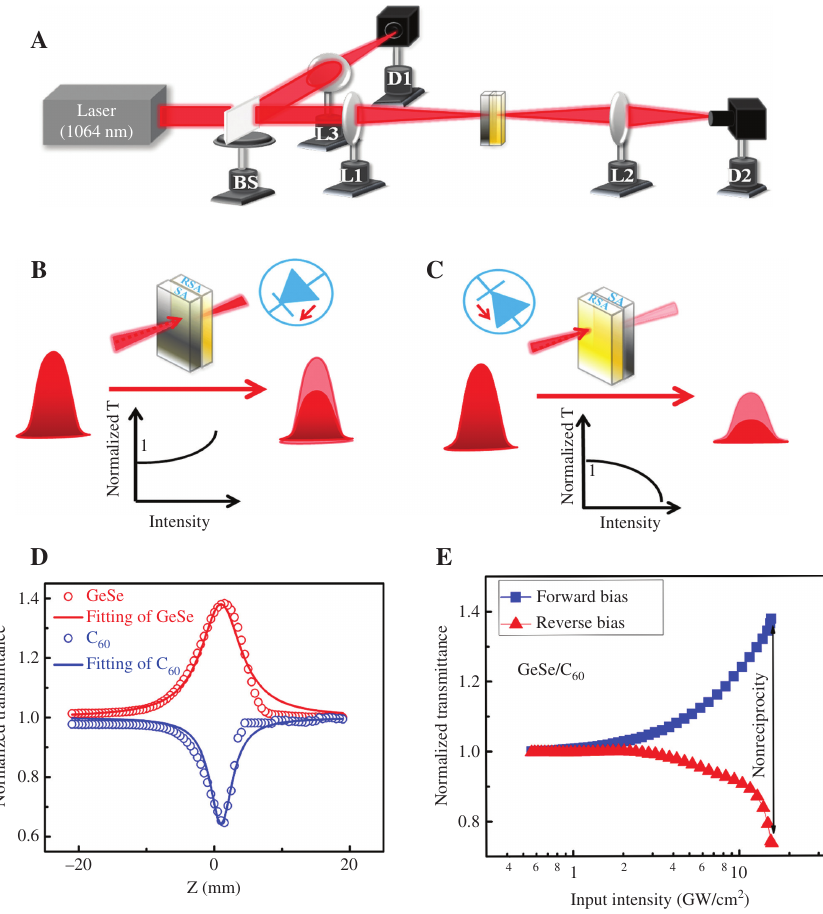
. Figure 5: The optical diode of GeSe/C 60 (A) Schematic diagram of the experimental setup; (B), (C) action of an all-optical diode based on asymmetric nonlinear absorption; (B) in forward bias (SA followed by RSA), when light passes through SA, the transmittance is initially higher than the linear transmittance, and then attenuates when passing through RSA. If the SA effect is more pronounced than RSA, the total response will be an increase in the amount of light transmission, which is similar to the forward bias of the electron diode. And (C) is on the contrary. (D) The OA Z-scan curves of the GeSe NP dispersions and C dispersions; SA of GeSe NPs in red and RSA of C in blue. (E) Optical diode behavior of the GeSe/C 60 60 60 bilayer structure; the forward bias in red and reverse bias in